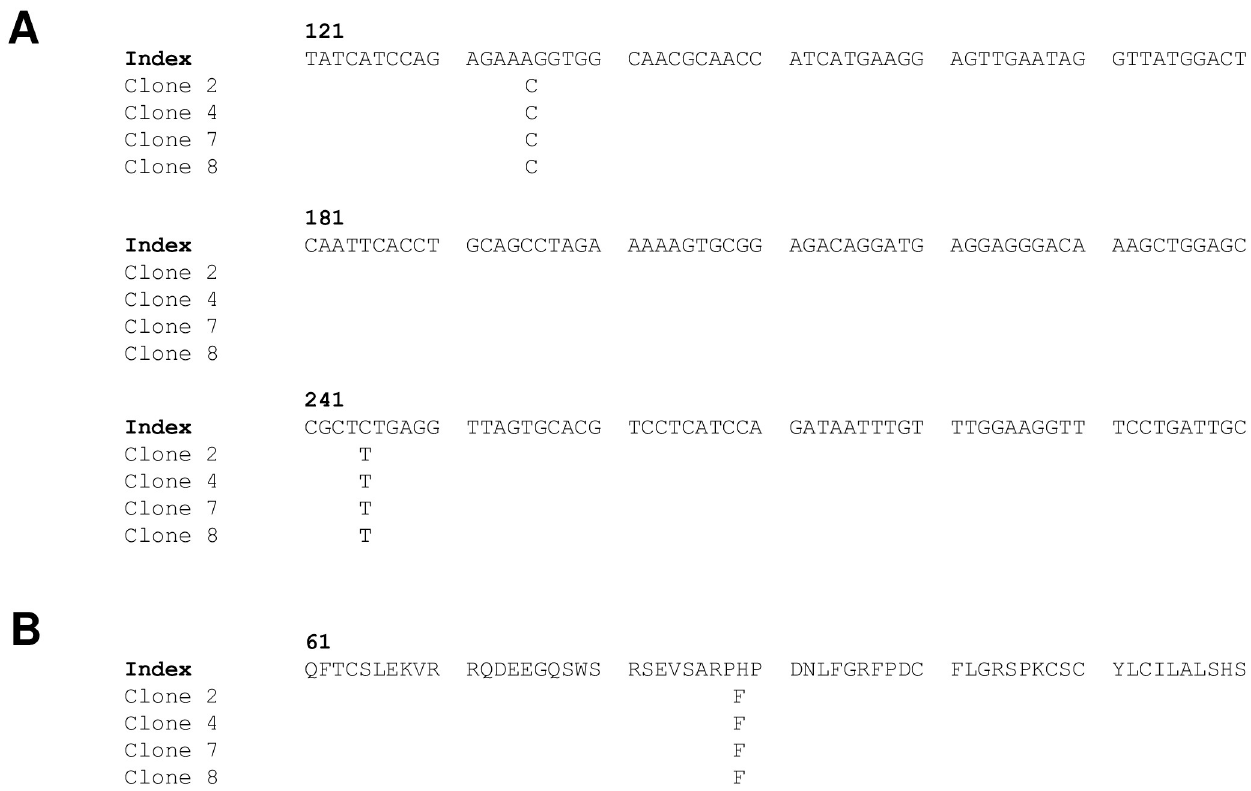
Fig 4. Predicted amino acid alignment. PAelPyV-1-Tag clones 2, 4, 7 and 8 partial nucleotide (A) and amino acid (B) alignment compared to the AelPyV-1 index genome (GenBank accession # NC-0225191.9).